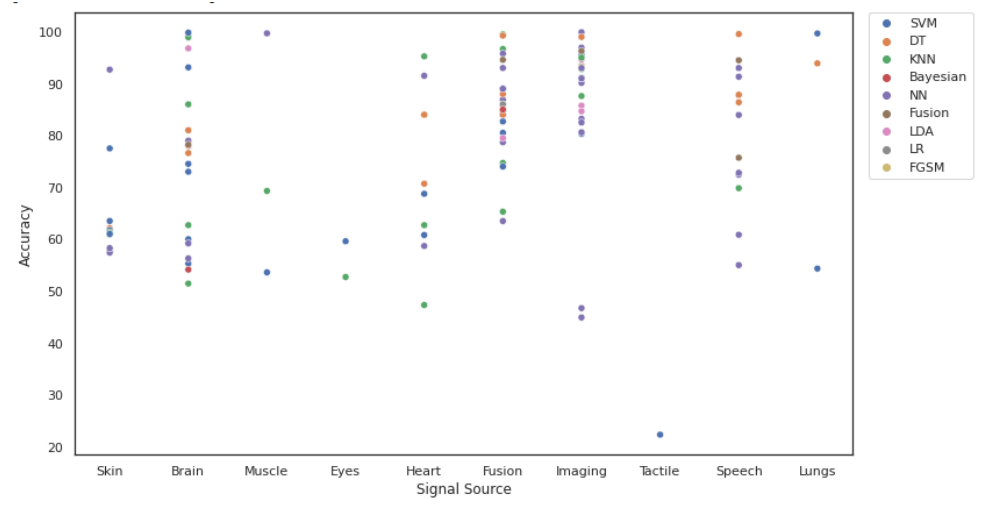
Figure 5. Scatter plot for the discrete emotional category. Table 1. Summary of the included papers in the discrete emotional